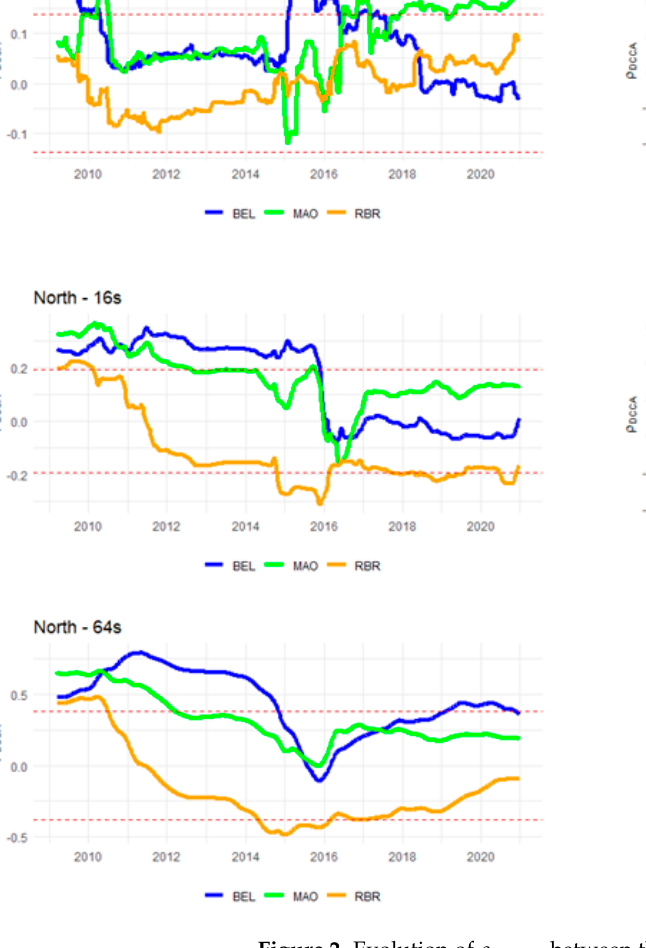
Figure 2. Evolution of ρ DCCA between the relative prices of S ã o Paulo and other capitals in the North Region, with time scales of 4, 8, 16, 32 and 64 weeks, and moving window w = 250. Shaded lines are the upper and lower confidence intervals, in the sense that values between these are not statistically significant, according to the critical values of